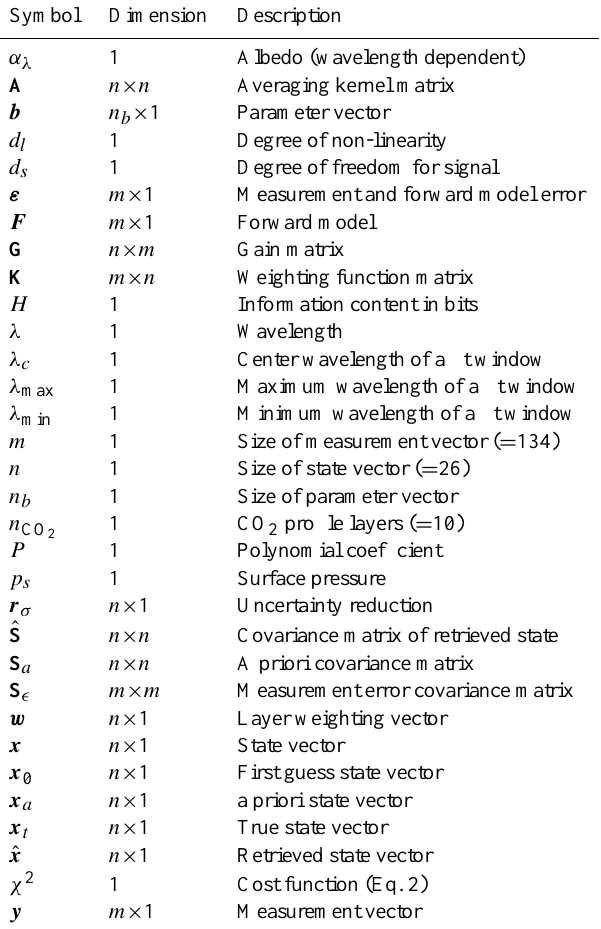
Table 1. List of used symbols and corresponding dimensions and short